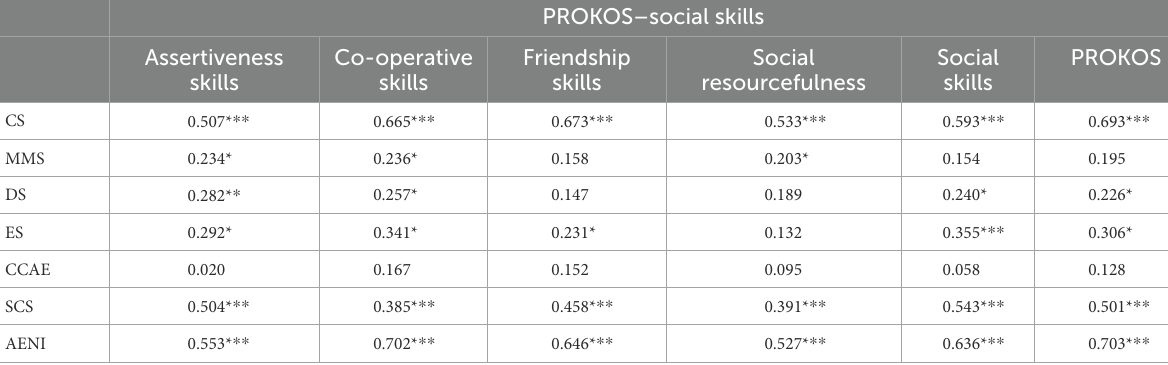
TABLE 8 Coefficient values in the correlation of measurements between AENI and PROKOS ( N =